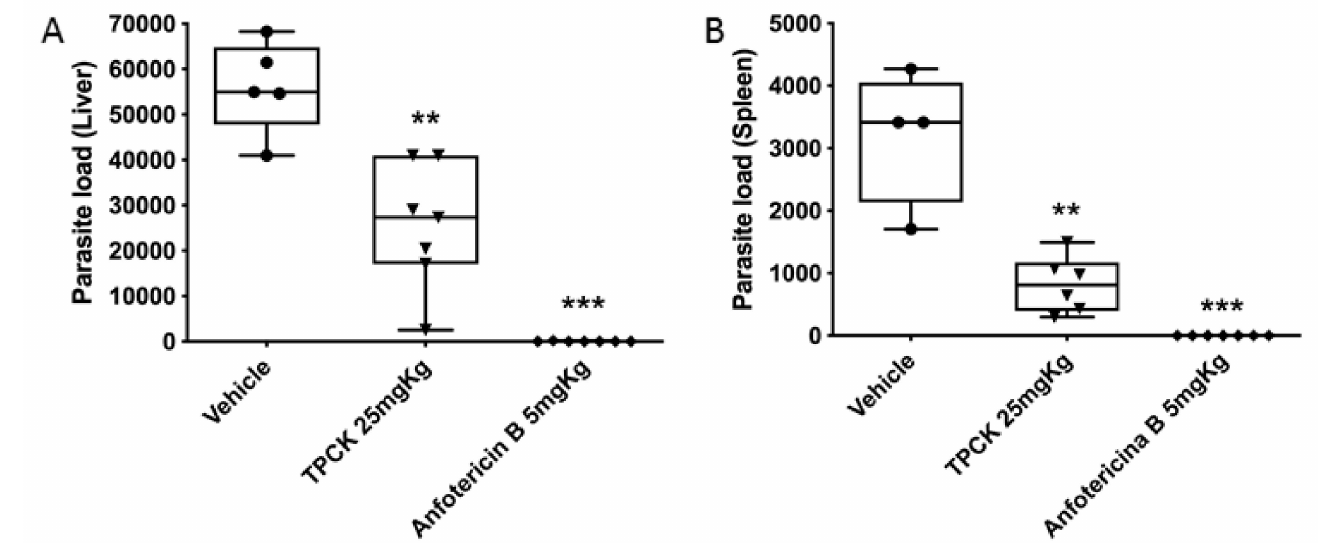
Figure 11. In vivo TPCK effect in a murine model for visceral leishmaniasis . BALB/c mice were infected intraperitoneally with 2.5 × 10 7 stationary-phase L. infantum promastigotes. Seven days after infection, the animals were treated with TPCK at 25 mg/kg/day intraperitoneally for 10 days. The control group received vehicle (PBS-Tween 80 0.05%). ( A ) Parasite load in the liver (parasites/liver). ( B ) Parasite loads in the spleen (parasites/spleen). Statistical differences between mean values were evaluated by the non-parametric Student t -test: ** p < 0.01, *** p <